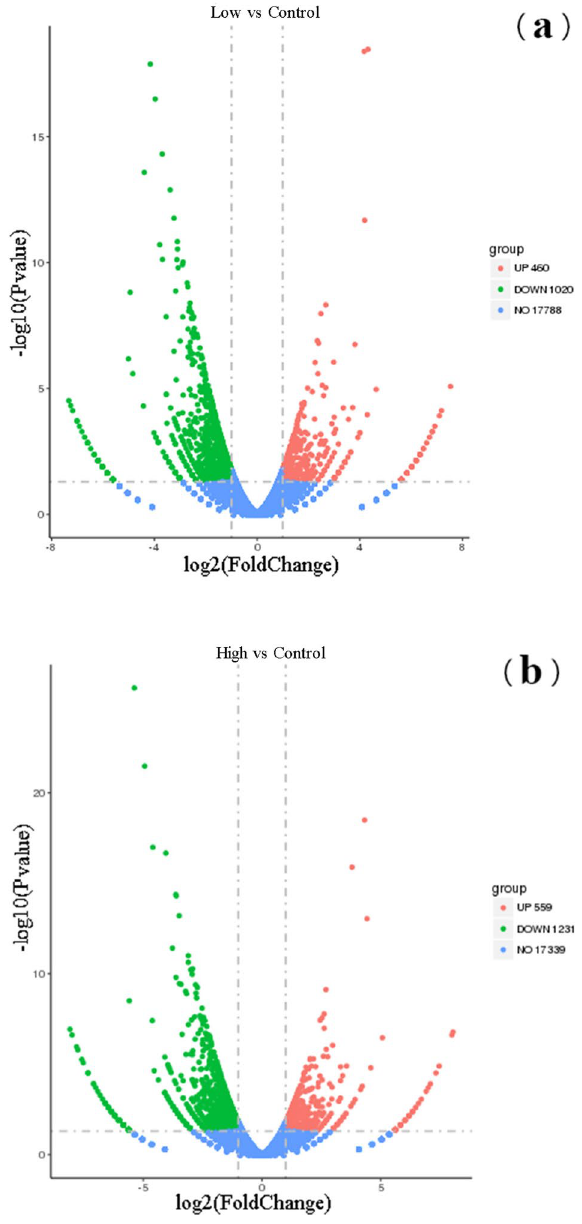
Figure 3. Volcanic map of DEGs between exposed and unexposed PC12 cells in the ICF experiment of "SG- III" prototype laser facility (Abscissa is log2 FoldChange, ordinate is -log10 ( P -value), blue dotted line represents the threshold line of differential gene screening